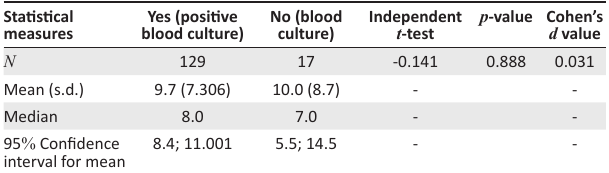
TABLE 2: A comparison of the average duration of treatment between patients with blood cultures and patients without blood cultures. Statistical